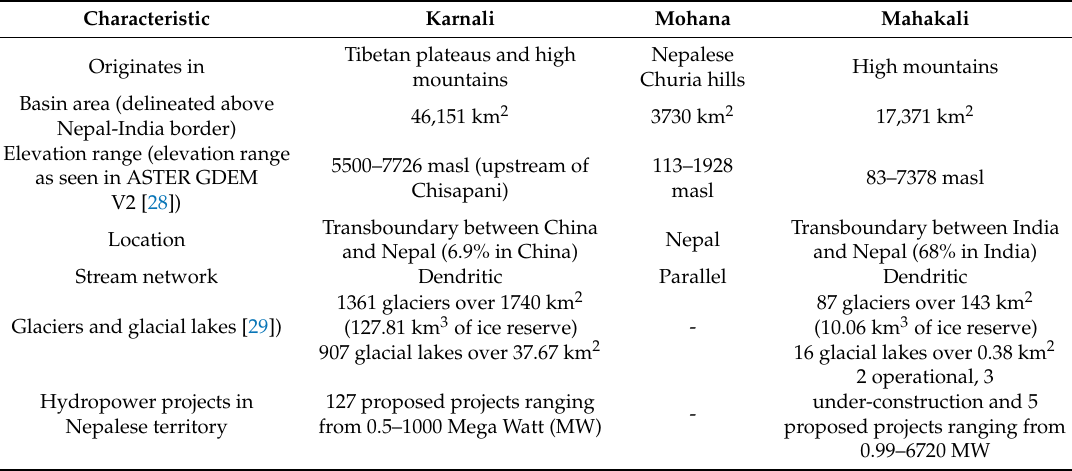
Table 1. Bio-physical characteristics of the three river basins in Western